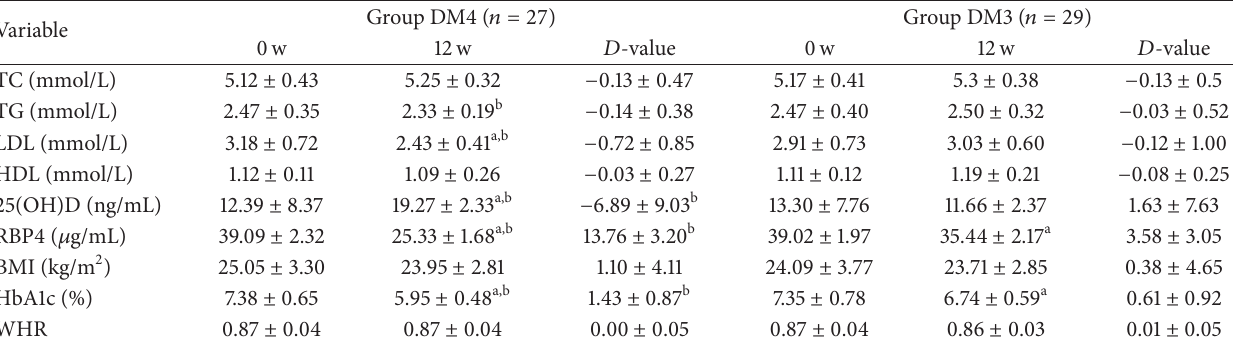
Table 3: The comparison of characteristics before and after treatment in Groups DM3 and DM4.